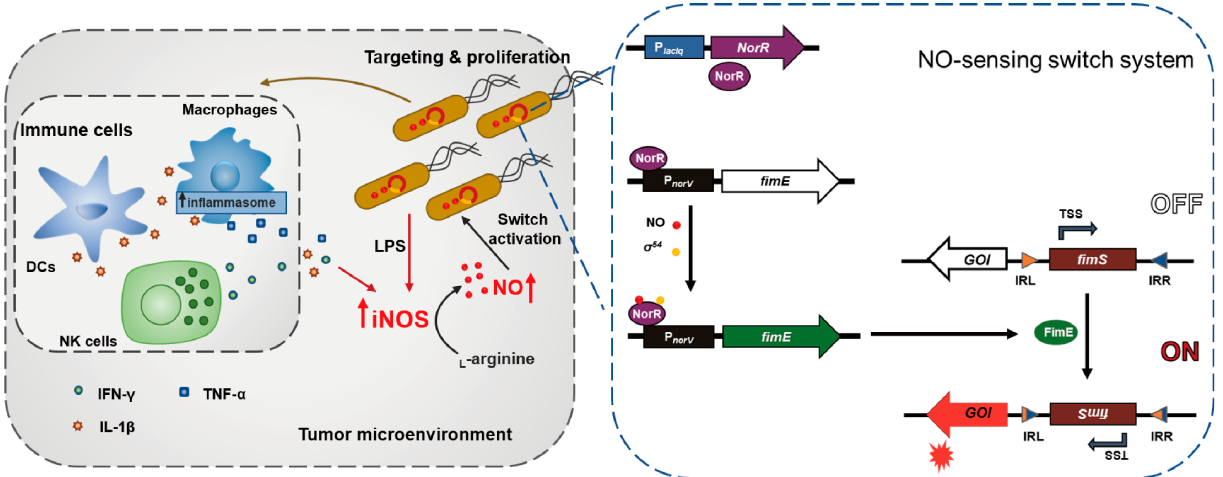
Figure 1. Conceptual illustration of this study. Colonization by and proliferation of SL . Δ ppGpp in tumor regions can lead to recruitment and activation of innate immune cells, such as macrophages, dendritic cells (DCs), and natural killer (NK) cells. Proinflammatory cytokines secreted by immune cells, including interferon (IFN)- γ , tumor necrosis factor (TNF)- α , and interleukin (IL)-1 β , as well as bacterial components, such as lipopolysaccharide (LPS), can upregulate the expression of iNOS, thus generating high levels of NO. NO binding to NorR can recruit σ 54 and release the suppression by NorR of the norVW promoter P norV , resulting in transcription of FimE recombinase. FimE can function on the inverted repeat left (IRL) and right (IRR) regions flanking fimS , which contains a promoter region, leading to the inversion of fimS and expression of the gene of interest (GOI). TSS, transcription start site.